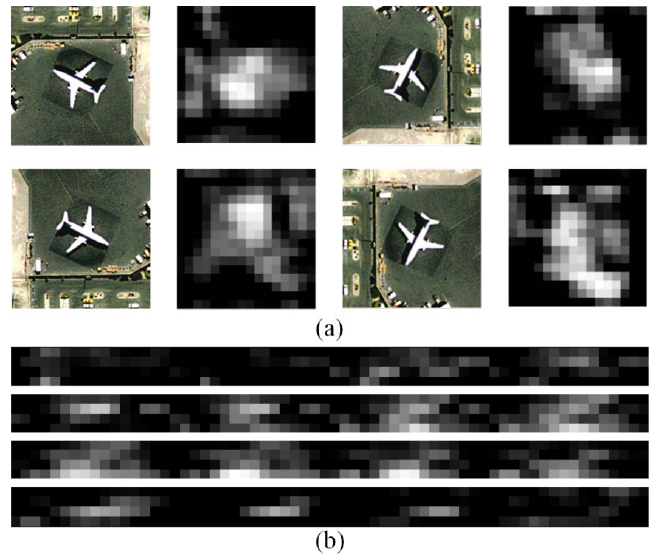
Figure 2. The rotation variation problem in CNNs for remote sensing scene classification. ( a ) One channel of feature maps extracting by the last convolutional layer of VGG-VD16 for each image; ( b ) We flattened each feature map in ( a ) into one-dimensional representation, split them into four parts, and put each part in different subgraph for visualization. Each row in a subgraph is corresponding to different image in ( a ).